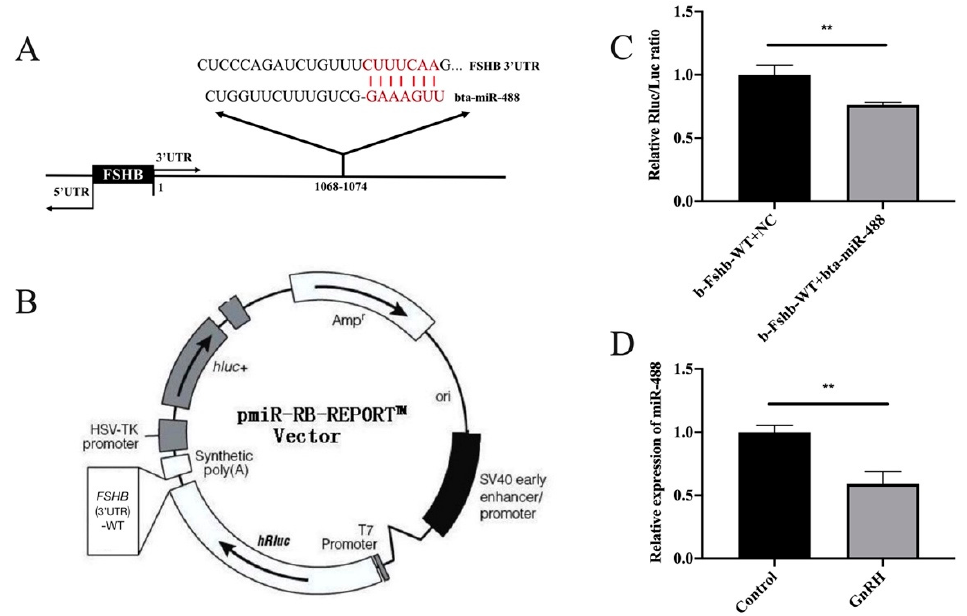
Figure 2. MiR-488 targeted the FSHB 3’UTR. ( A ) The complementary base pairing region of miR-488 and FSHB predicted through TargetScan program is shown in red. ( B ) The vector map of pmiR- RB-REPORT TM Vector. ( C ) The relative luciferase activity was measured after the co-transfection of pmiR-Fsh β -3’UTR-WT with the miR-488 negative control and mimic. ( D ) The expression of miR-488 after GnRH analogue treatment in bovine anterior adenohypophyseal cells. All experiments were repeated at least three times. Data are presented as the means ± SD. p < 0.05 was considered significant. When p < 0.01, ** was used to show the significance of the